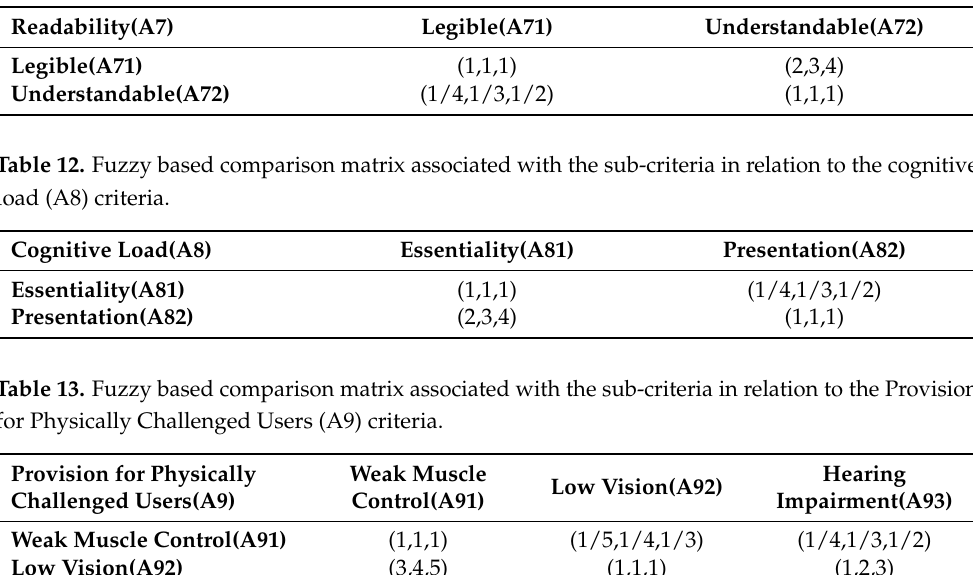
Table 11. Fuzzy-based comparison matrix associated the sub-criteria in relation to the -readability (A7) criteria.